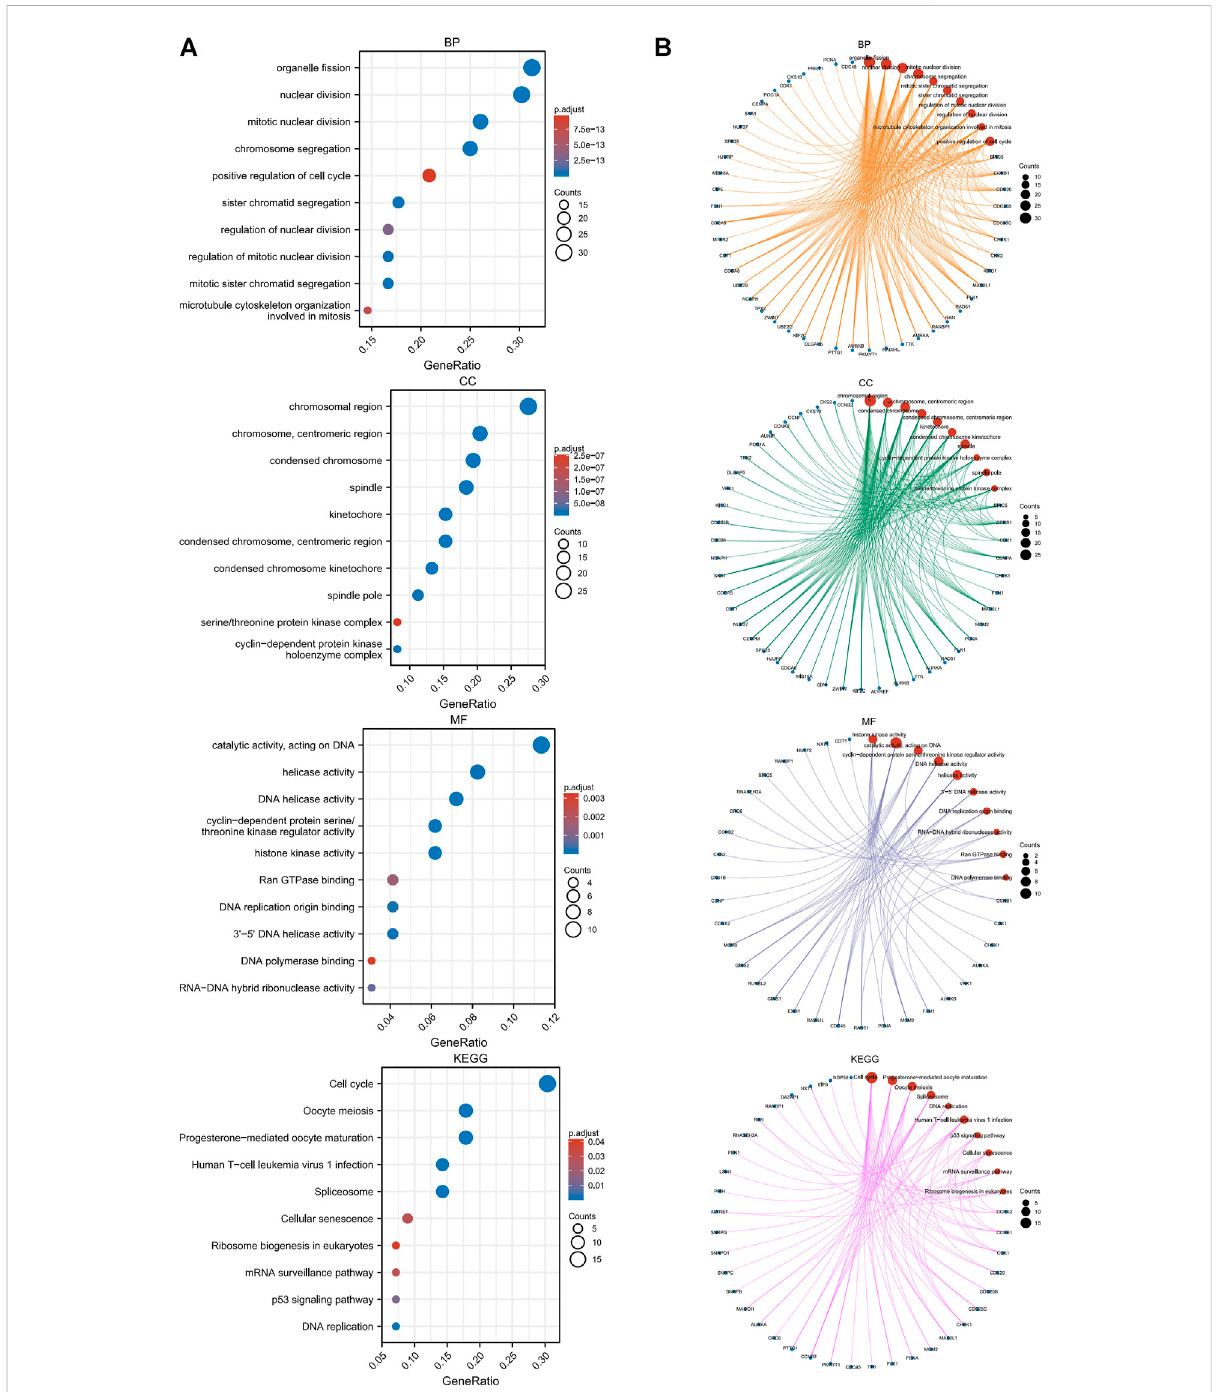
FIGURE 10 GO and KEGG enrichment analyses of SNRPB and the top 100 coexpressed genes across tumors. (A) . GO [in biological process (BP), cellular component (CC), molecular function (MF)] and KEGG enrichment analysis. (B) . Crosstalk between enriched BP, CC, MF, and KEGG functions and